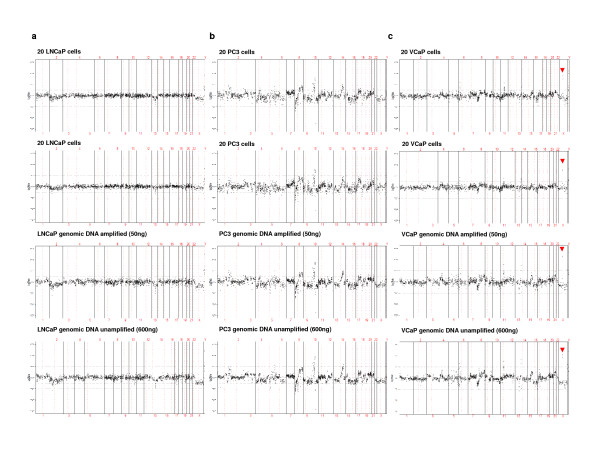
Copy number analysis of spiked cells isolated from healthy blood via IE/FACS. Twenty (20) isolated (A) LNCaP, (B) PC3 and (C) VCaP cells (in duplicate) and 50 ng of genomic DNA from cell culture subjected to whole genome amplification, and unamplified genomic DNA (600 ng) from cell culture (positive control) were analyzed for copy number aberrations. The log2 ratio value for each BAC clone is plotted on the y-axis. The x-axis represents the genomic position of each BAC clone on the array, with chromosome numbers indicated. Vertical solid lines indicate chromosome boundaries, and vertical red dashed line represents the centromeric region dividing each chromosome into the p- or short arm (to the left of centromere) and the q- or long arm (to the right of the centromere). Arrows indicate high-level gains on X chromosome region containing AR observed in VCaP cells.